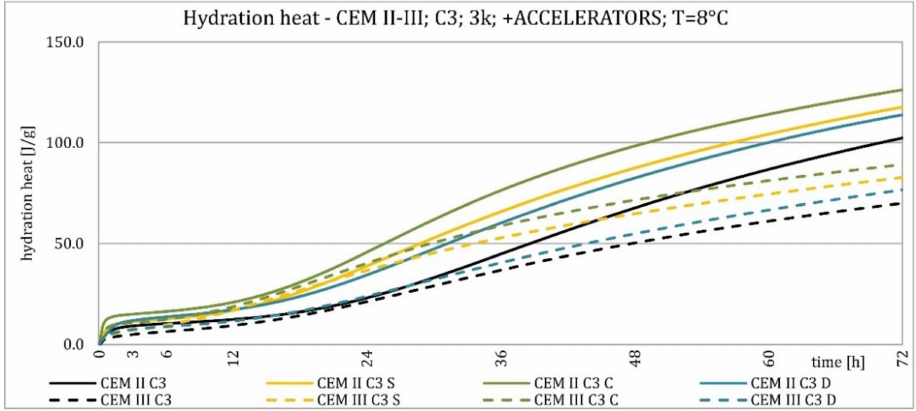
Figure 31. Hydration heat of C3 clinker-based cements CEM II/B-S, CEM III/A modified with accelerators at 8 ◦